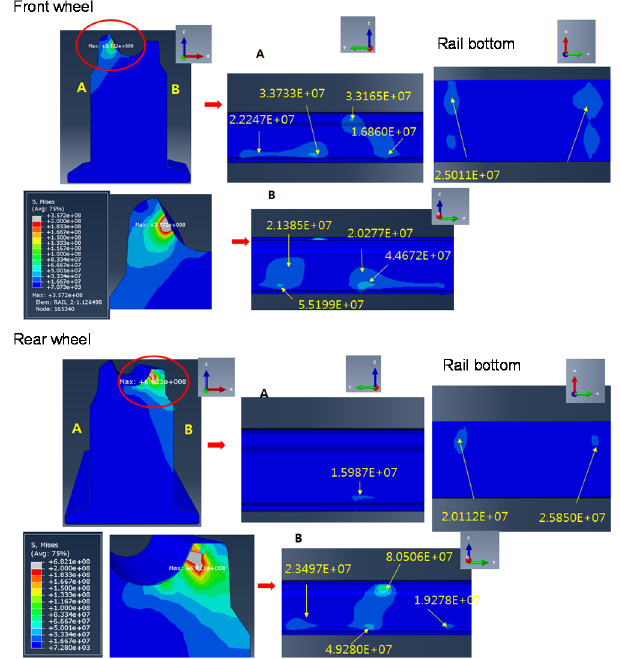
Figure 14. Structural analysis results (von Mises stress) of the rail when the wheels are placed between the railroad ties.